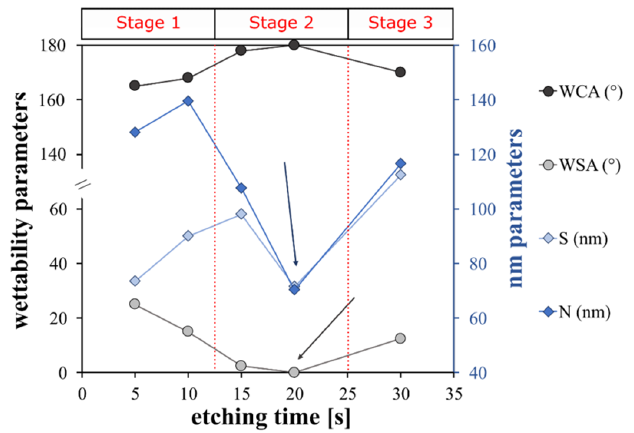
Figure 6. Correlation between wettability and surface parameters.